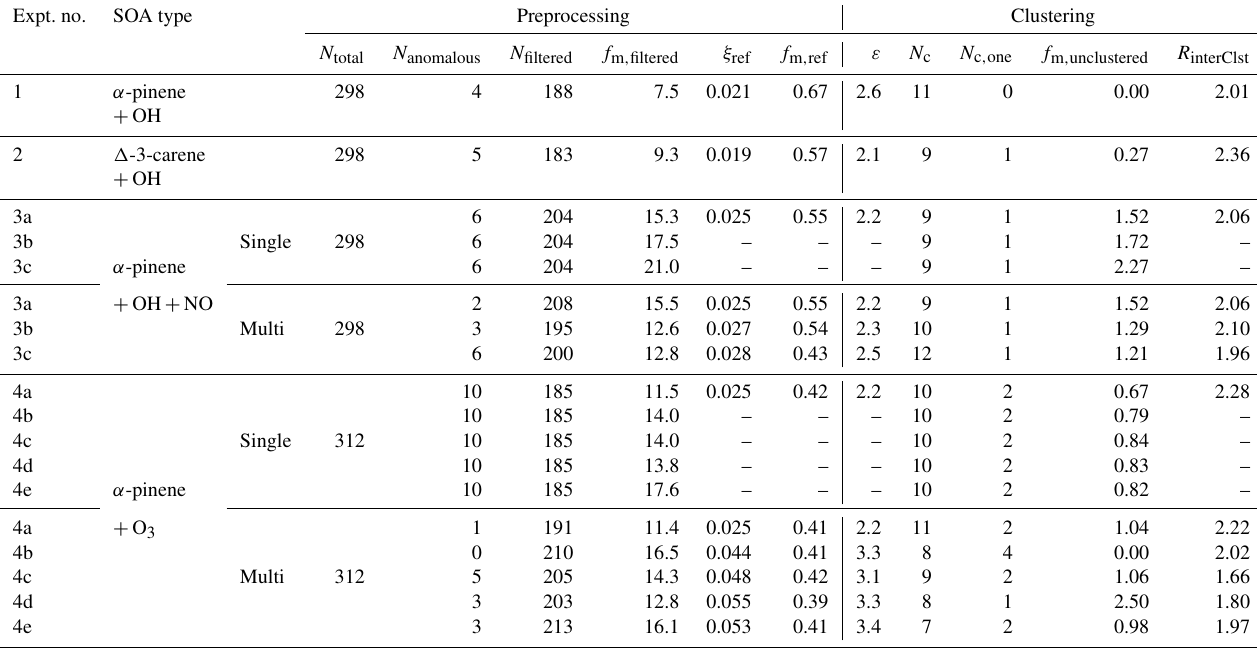
Table 3. Parameters and thresholds used for the data processing and noise-sorted scanning clustering for all the example experiments. Expt. no.